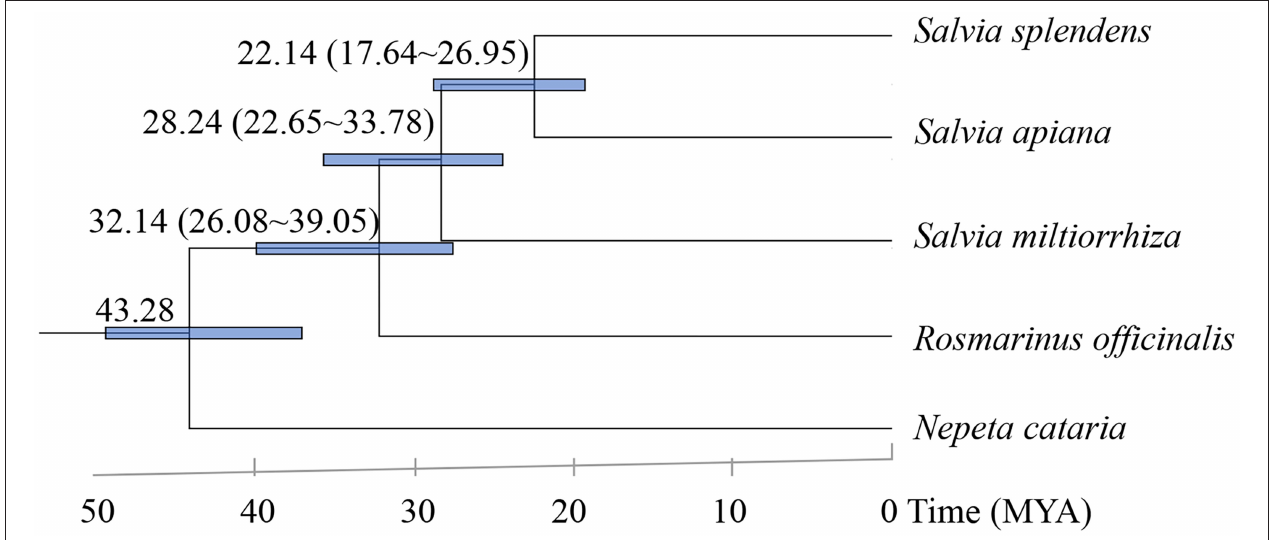
FIGURE 3 | Phylogenetic tree of five plant species. Blue numerical value beside each node shows the estimated divergence time of each node (MYA, million years ago).